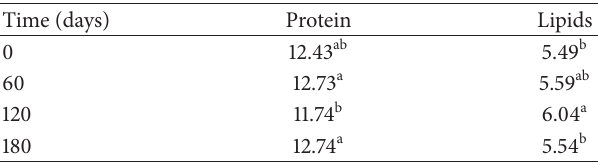
Table 3: Fatty acids in the minced tilapia (g/100 g). Fatty acids